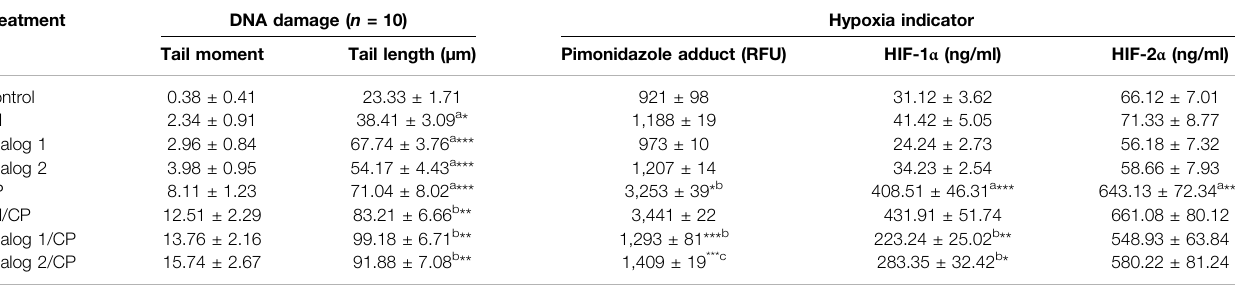
TABLE4| AnalysisofDNAdamageandhypoxiaindicators:DNAdamagehasbeenanalyzedbycometassayinBMCs,whilehypoxiahasbeenmonitoredinlymphocytesby the determination of total hypoxia/pimonidazole adducts, HIF-1 α , and HIF-2 α in lymphocytes. Cells from different mice groups have been investigated after 24 h from administration of TH and analogs in absence and presence of CP. The data are represented as mean ± S.E.